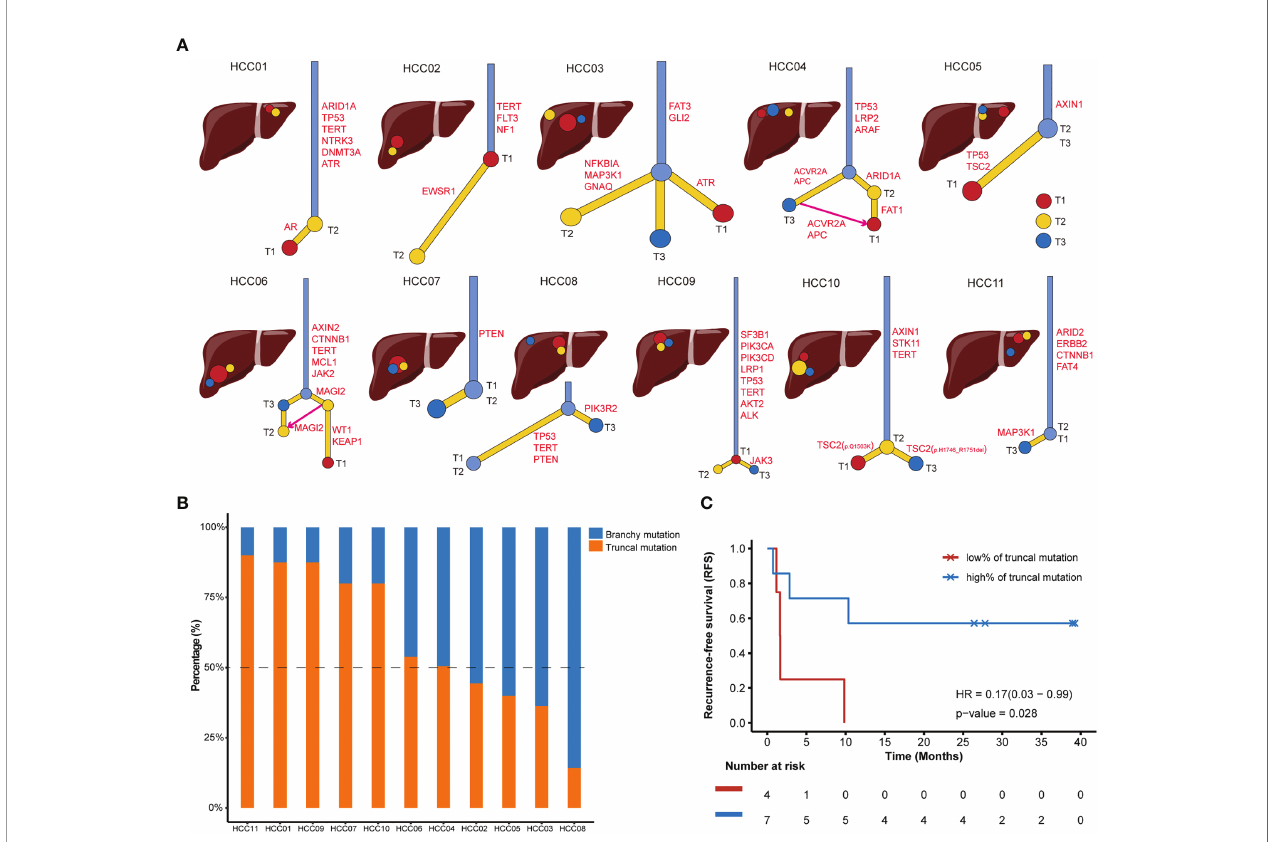
FIGURE 2 | Phylogenetic trees of multifocal HCC cases and recurrence outcomes after radical surgical resections. (A) Phylogenetic trees are constructed using somatic mutations. Intrahepatic tumoral focal are arrayed in the liver around the anatomical diagram. T1 is the red circle, T2 is the yellow circle and T3 is the blue circle. The putative HCC driver mutations are also annotated in the trunks or branches of phylogenetic trees. (B) The tumor mutation burden (TMB) value and percentage of truncal mutations and branchy mutations in each patient with multifocal HCC. Blue bar and orange bar represent the proportion of branchy mutation and truncal mutation, respectively. (C) Kaplan-Meier curve showing poor recurrence-free survival (RFS) in patients with a low ratio (<50%) of truncal mutation (Log-rank